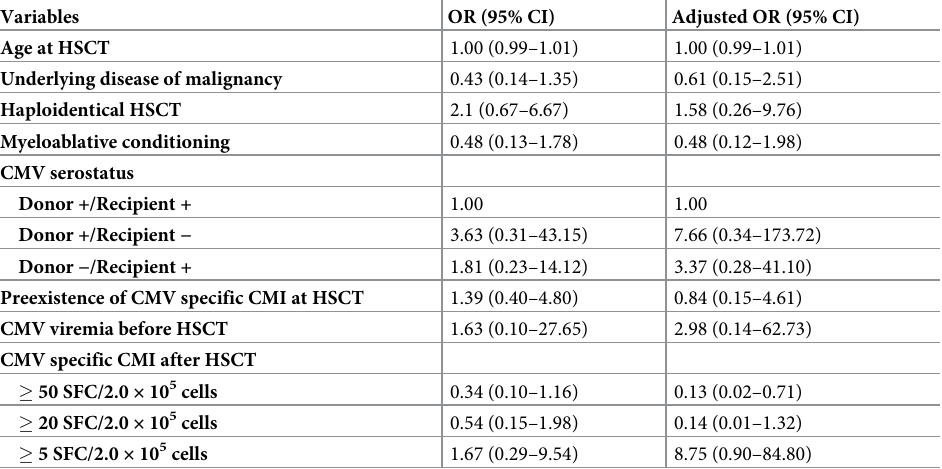
Table 3. Factors associated with clinically significant CMV infections following